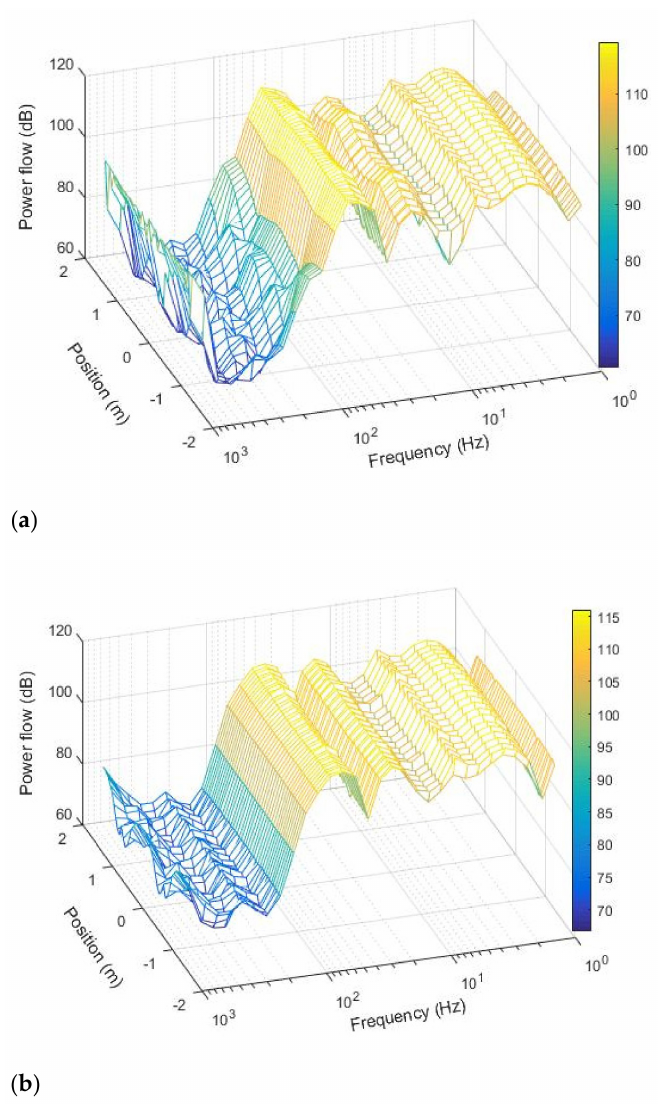
Figure 10. Sleeper longitudinal power flow distribution: ( a ) composite sleeper; ( b ) type-III pre- stressed concrete sleeper.